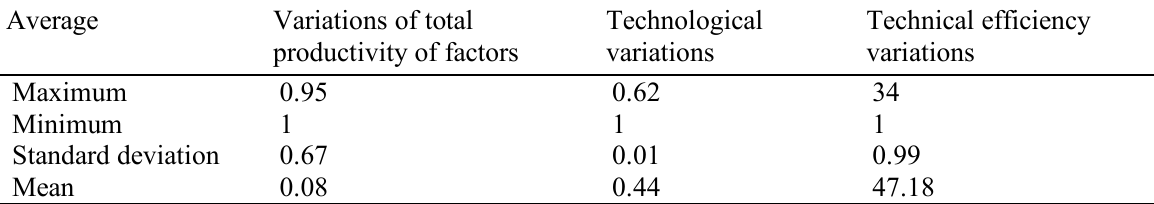
Table 7. The rate of annual variations of Malmquist productivity index in Zehak County Average Variations of total productivity of factors Maximum 0.94 Standard deviation